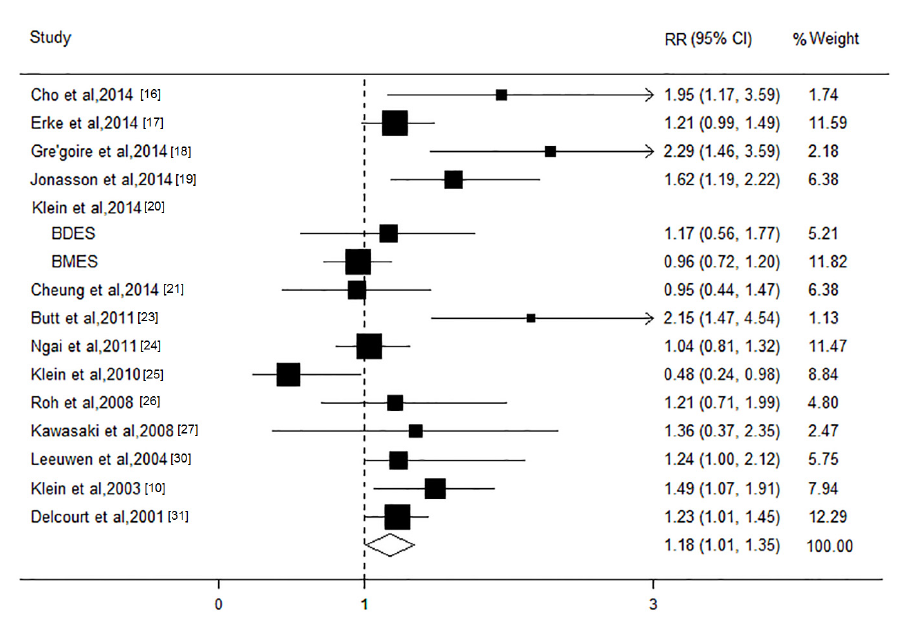
Figure 2. Forest plot on the associations between the high-density lipoprotein level and age-related macular degeneration. The boxes and lines indicate the relative risks (RRs) and their 95% confidence intervals (CIs) on a log scale for each study. The pooled relative risk is represented by a diamond. The size of the black squares indicates the relative weight of each estimate. BDES, the Beaver Dam Eye Study; BMES, the Blue Mountains Eye Study.